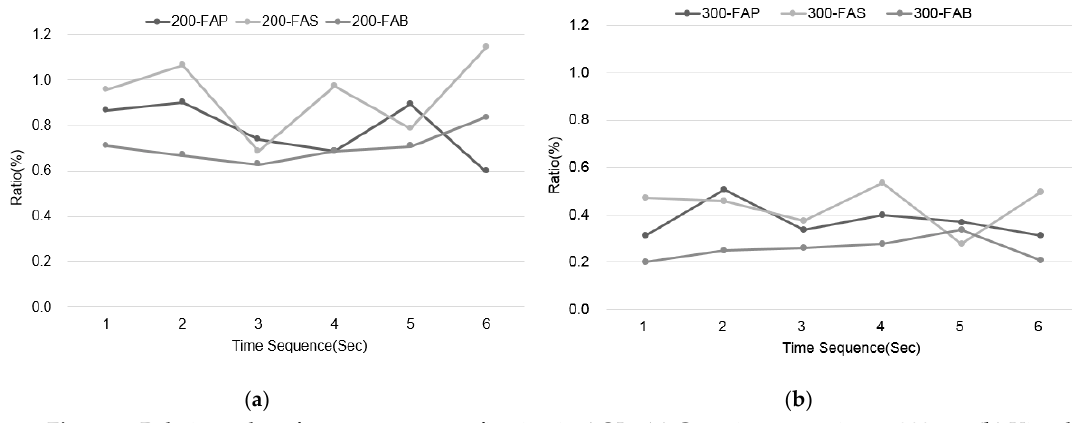
Figure 7. Relative values for eye-movement fixation in AOIs. ( a ) Conscious attention at 200 ms. ( b ) Visual understanding at 300 ms.